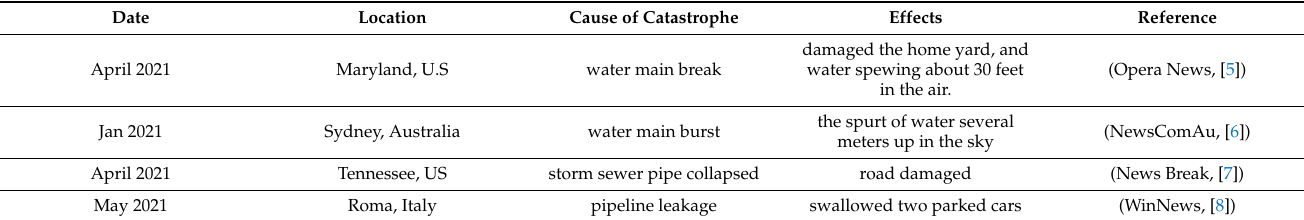
Table 1. Examples of recent sinkhole events induced by water mains defect.